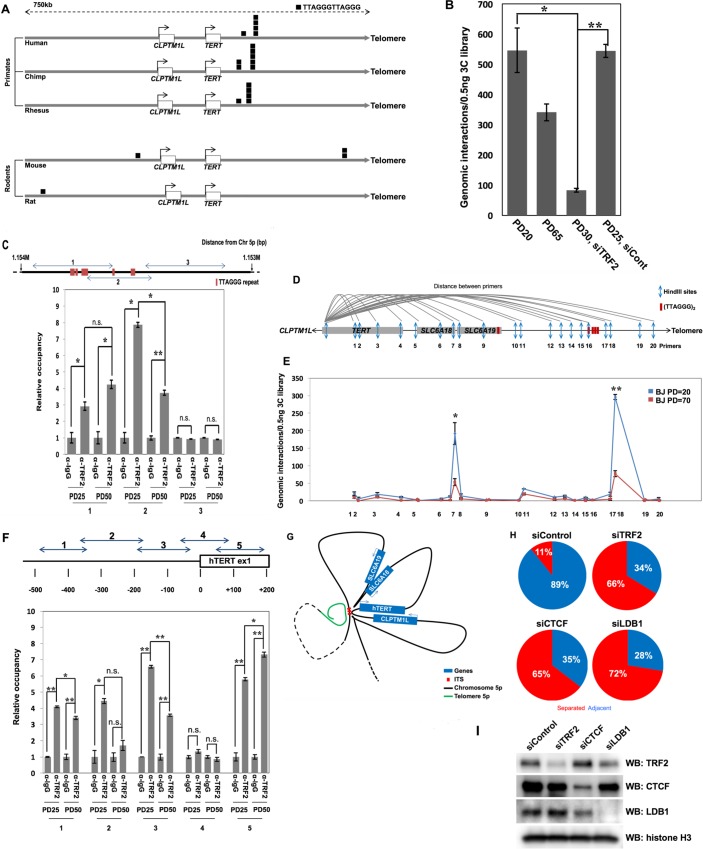
TRF2 as a mediator of telomere looping between the hTERT and sub-telomeric 5p in cells with long telomeres.(A) The number of (TTAGGG)2 repeats was analyzed on a small series of mammalian genomes. The TERT locus flanked by 350kb was examined. The (TTAGGG)2 repeats are depicted as a single black box. Multiple (TTAGGG)2 repeats at a locus are depicted by stacked black boxes. Transcription orientation of TERT and location of telomere are shown in figure. (B) 3C analyses show distal genomic interactions between the 5p telomere and hTERT. 3C libraries were generated from BJ cells treated with siRNA against TRF2, followed by ddPCR amplification to determine genomic interactions. t test revealed a significant effect. *p < 0.05, **p < 0.01 (C) ChIP shows enrichment of TRF2 protein on hTERT-ITS. The 1.153 Mbp to 1.154 Mbp region from the end of the chromosome 5p was examined. Chromatin extracts from BJ cell at PD25 and PD50 were prepared and pulled down with an antibody against TRF2. TTAGGG repeats are depicted as a red box. (D) A schematic map of the human chromosome 5 at the 1,153,167 bp to 1,353,167 bp region from the p arm terminus. Arrows indicate location of HindIII restriction enzyme sites. Red boxes indicate location of TTAGGGTTAGGG repeats along the genome. (E) 3C analysis shows distal genomic interactions between 5`end of hTERT locus and each HindIII site. 3C libraries were generated from BJ cells at PD25 and PD70, followed by ddPCR amplification to determine genomic interactions. t test revealed a significant effect. *p < 0.05, **p < 0.01. (F) ChIP shows enrichment of TRF2 protein on the hTERT promoter. Chromatin extracts from BJ cell at PD25 and PD50 were prepared and pulled down with an antibody against TRF2. The hTERT promoter region from -500bp to +200bp was analyzed by real-time-qPCR. t test revealed a significant effect. *p < 0.05, **p < 0.05, n.s. = no significance. (G) Model of genomic folding at hTERT locus based on 3C analyses. Blue boxes indicate the location of genes on chromosome 5p. Red boxes indicate the location of hTERT-ITS. Blue and red dashes indicate chromosome 5p and telomere of chromosome 5p, respectively. (H) BJ cells at PD 17 were transfected in individual experiments with a siRNA against TRF2, CTCF, and LDB1. Three days after transfection, cells were fixed for 3D-FISH analysis. Percentage of adjacent allele (A) pairs versus separated allele (S) pairs was determined by 3D-FISH. (I) Western blotting analysis shows knockdown efficiency of the siRNA against TRF2, CTCF, and LDB1. Histone H3 was used as a loading control. Data associated with this figure can be found in the supplemental data file (S1 Data).